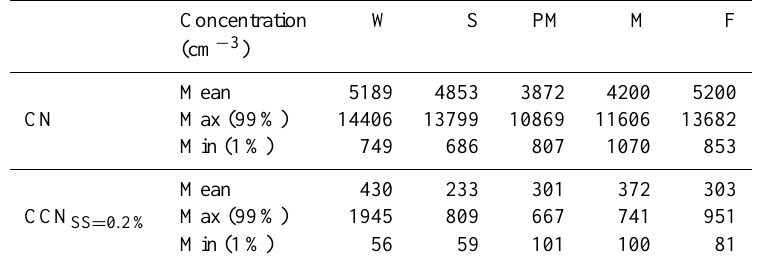
Table 1. Seasonal mean and extreme CN and CCN concentrations from hourly averaged data. Seasons are defined as follows: winter (W, DJF), spring (S, MA), pre-monsoon (PM, MJ), monsoon (M, JAS) and fall (F, ON). Concentration W S PM M F (cm − 3 ) Mean 5189 4853 CN